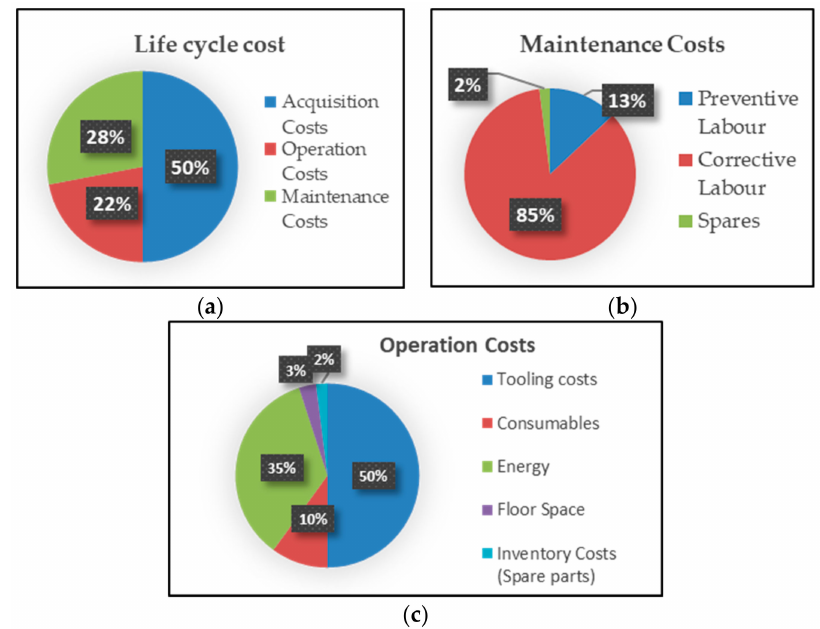
Figure 3. The life cycle cost for transfer machine. ( a ) Maintenance costs; ( b ) life cycle cost; ( c ) operation costs.